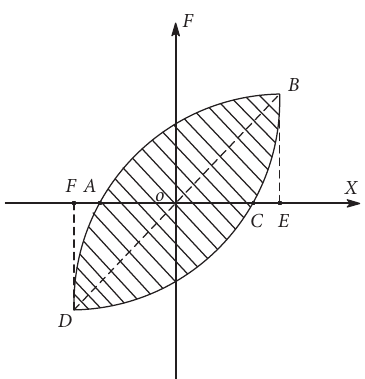
Figure 13: Comparison of skeleton curves.